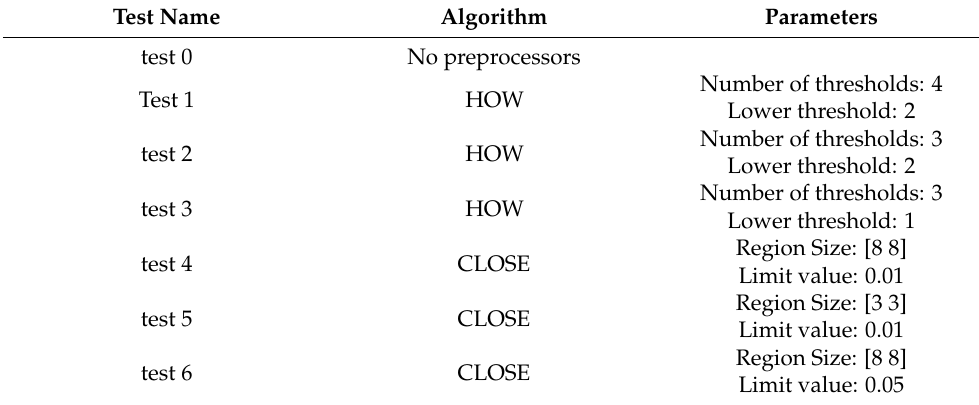
Table 4. Description of the tests carried